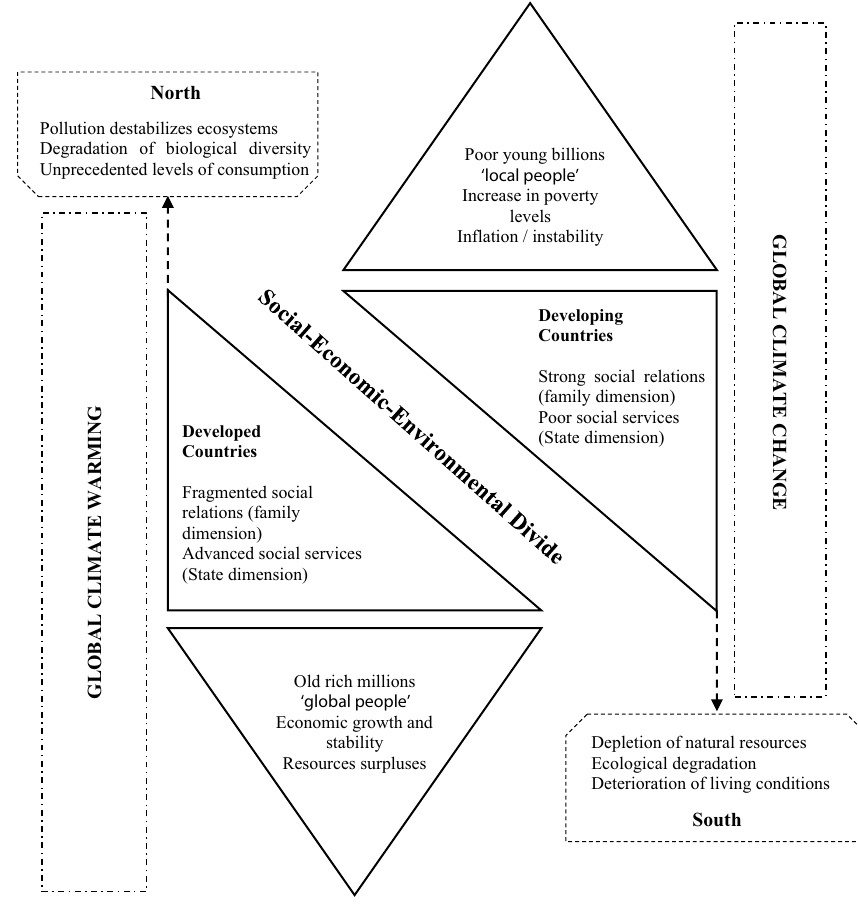
Fig. 3 Classical sustainabil- ity within a divided